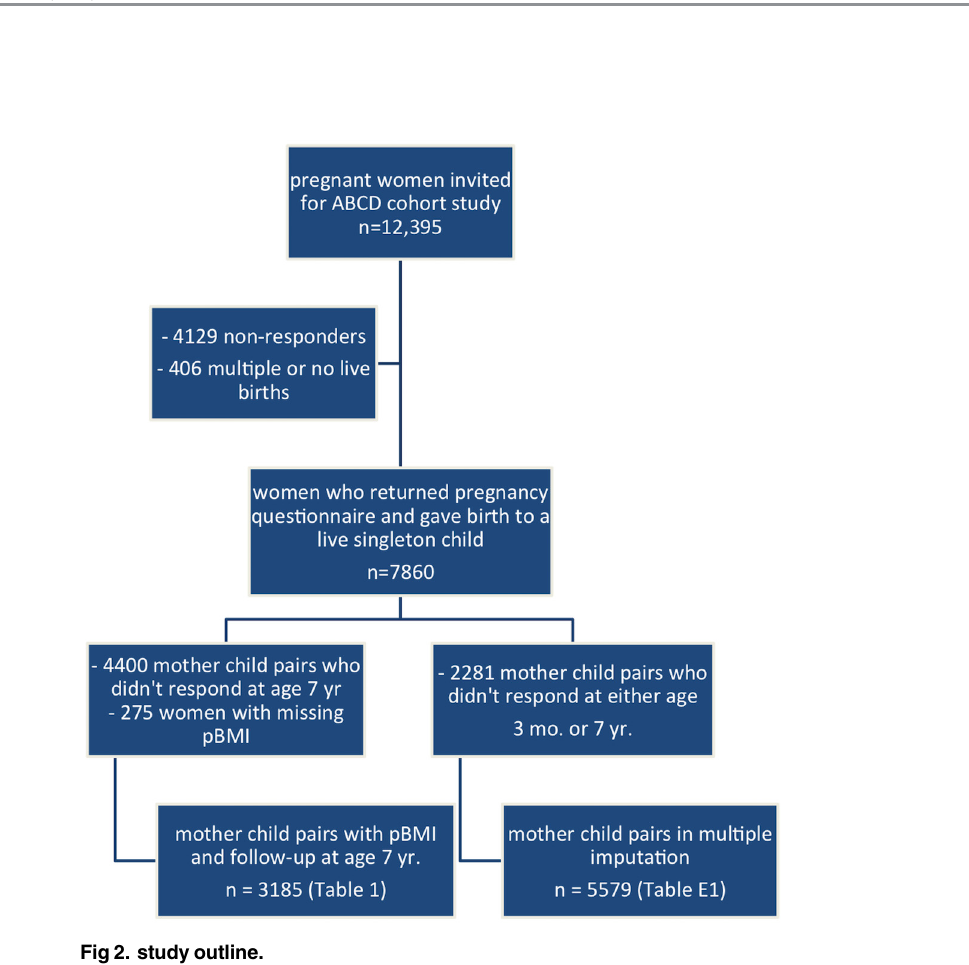
Fig 2. study outline.